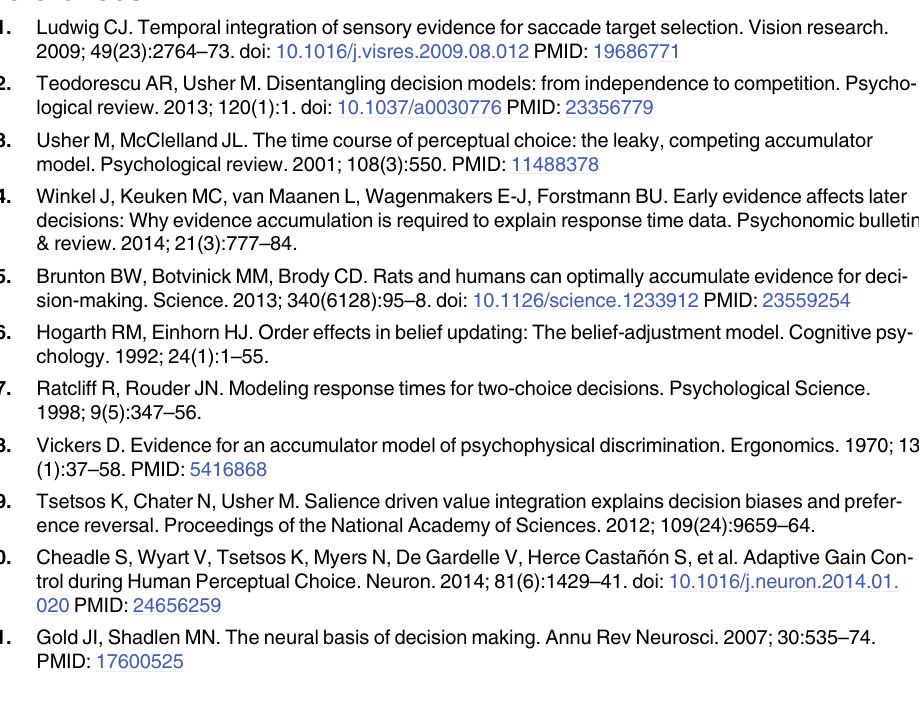
S4 Fig. Simulated temporal weights for 1- and 2-sec trials using a model, in which on some trials integration is primacy-biased (p_inhibition_dominance = 0.16; noise = 0.5; leak = 0.04; inhibition = 0.2) and on other recency-biased (p_leak_dominance = 0.84; noise = 0.5; leak = 0.2; inhibition = 0.025). Parameters were manually chosen to meet the non-monotonic pattern observed in the 3-sec trials. As can be seen, a model that assumes that on a fraction of trials accumulation is recency-biased, and on other trials primacy-biased pre- dicts non-monotonic weighting in 1- and 2-sec trails as well. S5 Fig. Observed and predicted temporal-weighting in Experiment 4 (N = 8), which was identical to Exp. 3, only with 5-sec trials rather than 3-sec trials. As can be see, observed weights are monotonically increasing indicating recency-biased integration. This pattern is predicted by the DLCA model. Simulation was conducted using the best-fitting parameters obtained for the 3-sec data. S1 Table. Models ’ parameter-space. Description of the